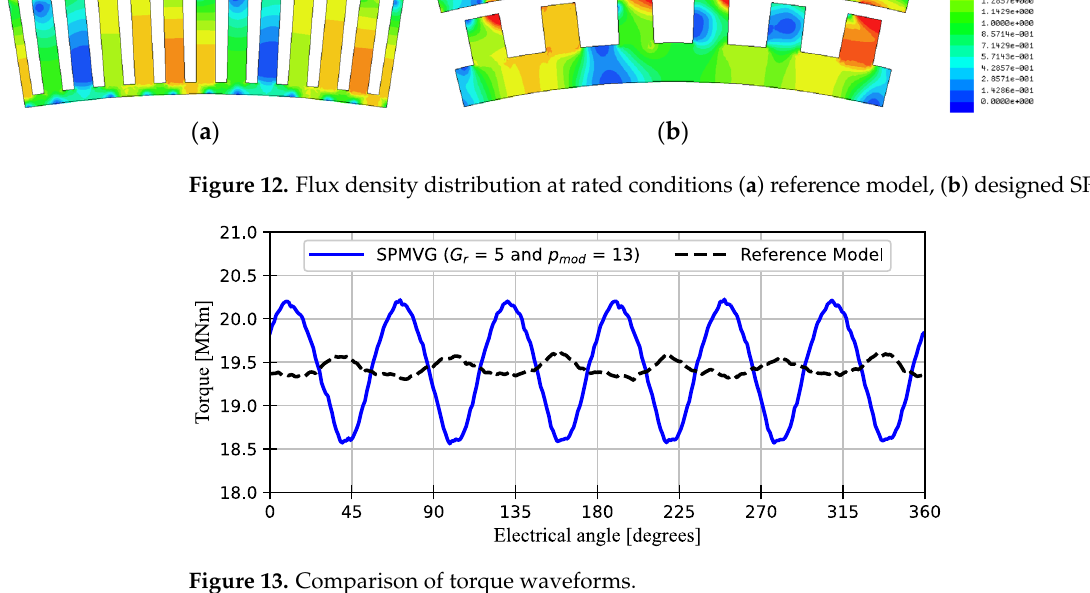
Figure 13. Comparison of torque waveforms.